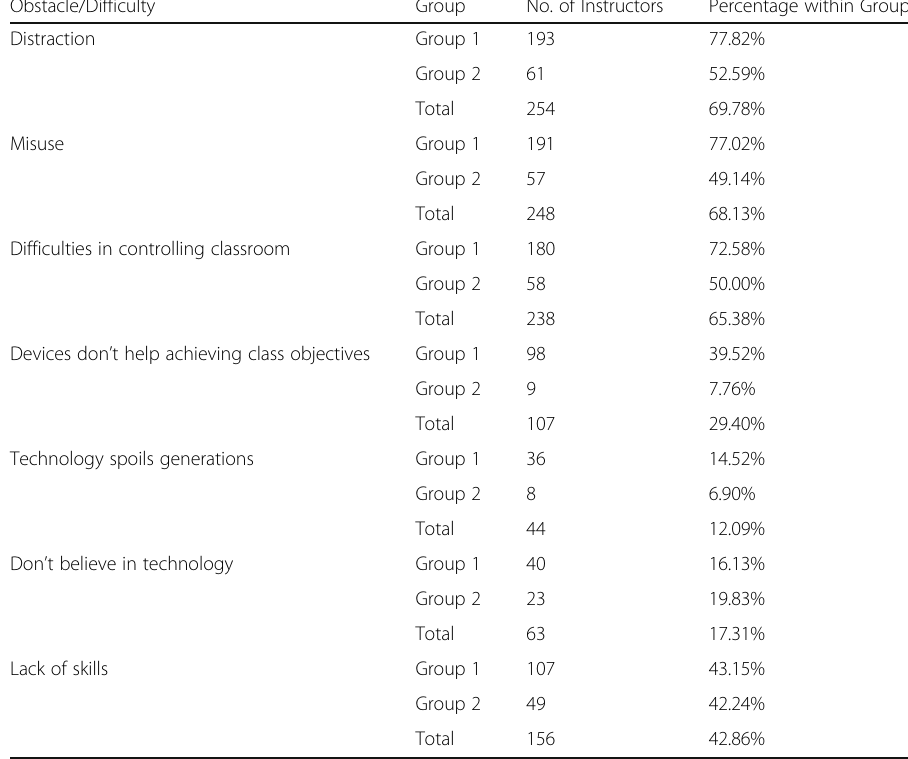
Table 2 Obstacles/difficulties facing the use of smart devices as reported by instructors and the number of occurrences